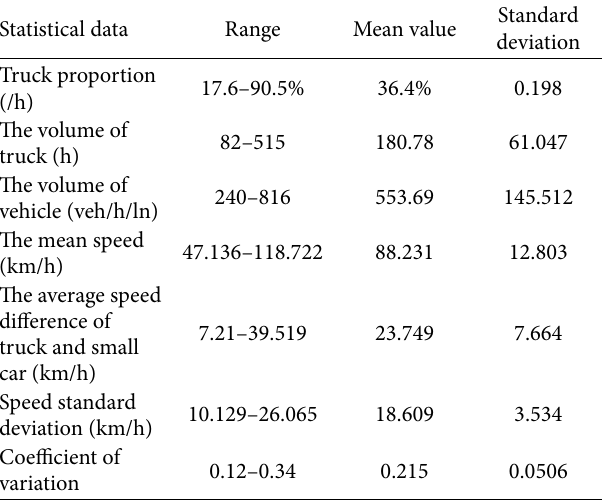
Table 1: The base information of collected data. Statistical